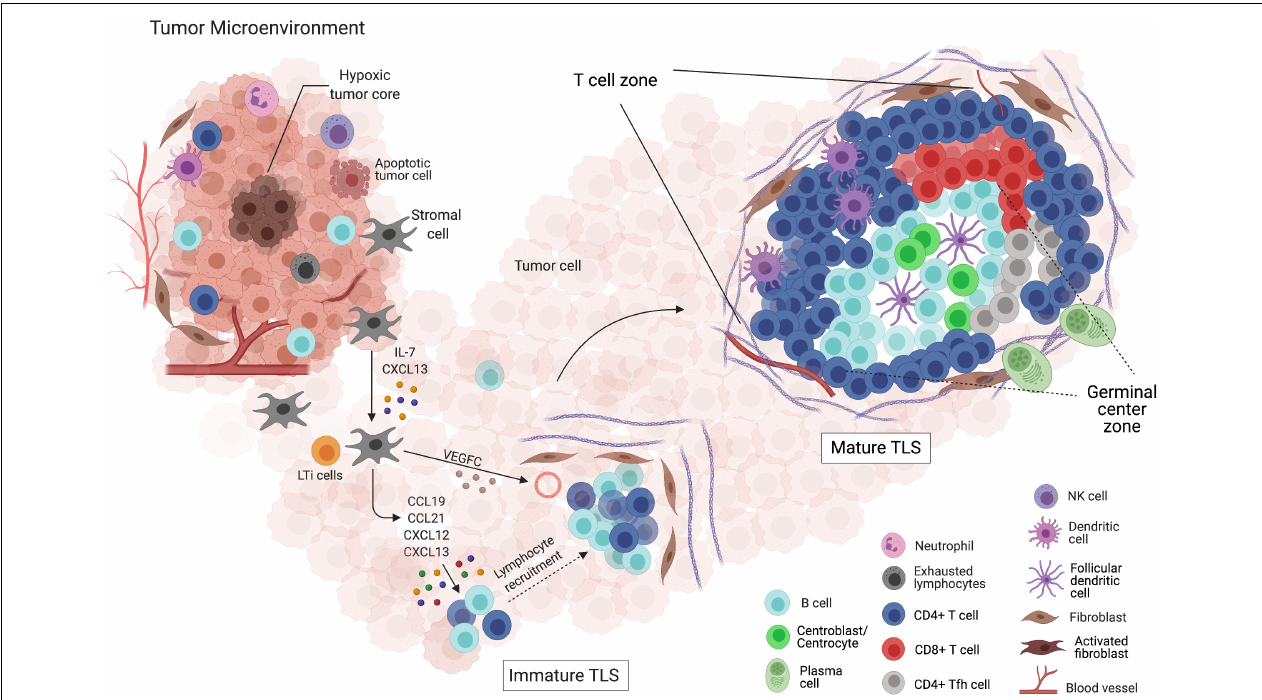
FIGURE 2 | Formation and maturation of tertiary lymphoid structures (TLSs) within the tumor microenvironment. (I) Depiction of the tumor microenvironment and its interactions with both innate and adaptive immune cells, and the non-immune components. (II) LTis attracted by the CXCL13 gradient, produced by activated stromal cells, migrate to the site of TLS initiation. Chemokines, such as CCL19, CCL21, CXCL12, and CXCL13, allow the migration and retention of additional LTis along with lymphocytes. The gathering of leukocytes surrounded by an extracellular matrix net produced by fibroblasts and newly formed blood vessels supports immature TLS formation, which fails to mount effective anti-tumor responses. (III) The presence of clearly delimited T cell and B cell zones, as well as a GC-like structure, defines mature TLSs. In this structure, the induction of plasma cells and memory B cells takes place, reflecting the interaction with other specific cell types, such as FDCs, T FH , and CD8 + T cells. Surrounded by pericytes and expressing adhesion molecules, the normal high endothelial venules (HEVs) located at the TLS vicinity favor the formation of mature TLSs, which are thought to be a rich niche of anti-tumor B and T cell